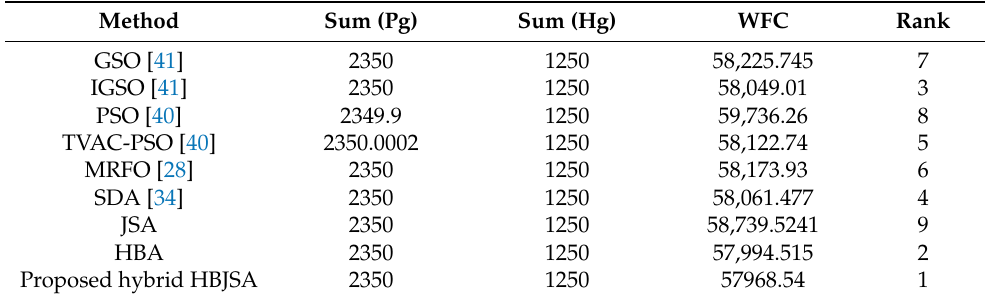
Table 2. Comparison between HBA, JSA, and HBJSA with respect to reported techniques for the 24-unit system of CHP economic dispatch.